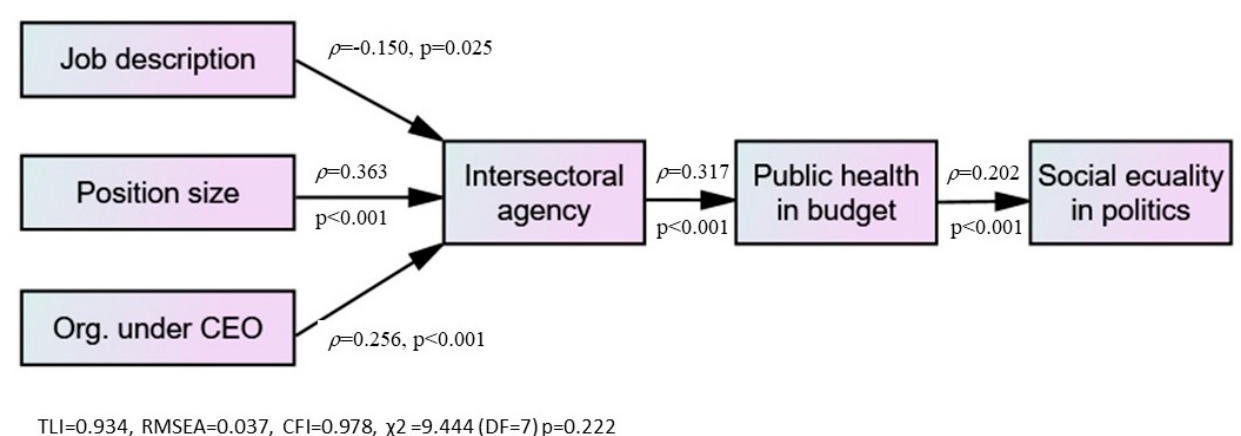
Figure 2. Final path